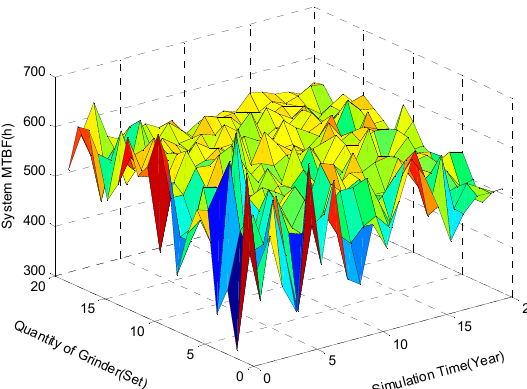
Figure 6. Point estimation comparison of different time and quantity of the computer numerical control (CNC) grinder.